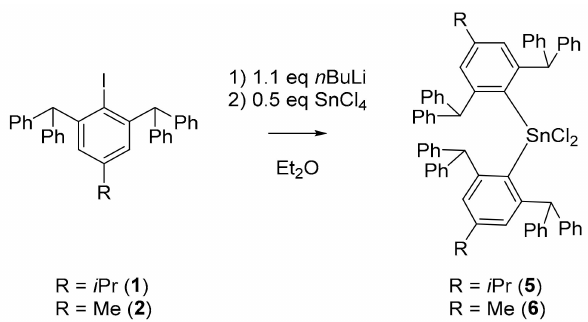
Figure 2. Synthesis of i Pr Ar* 2 SnCl 2 ( 5 ) and Me Ar* 2 SnCl 2 ( 6 ) from i Pr Ar*I ( 1 ) and Me Ar*I ( 2 ), respectively.